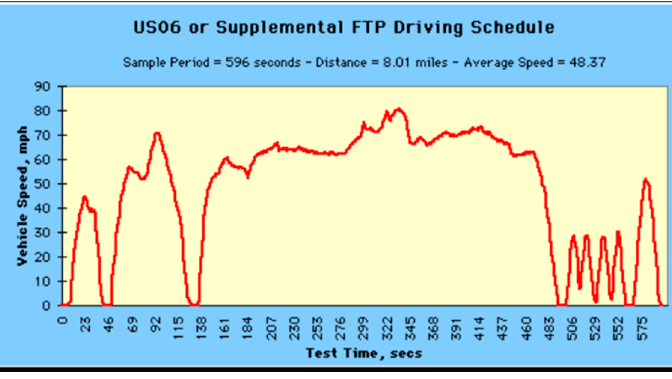
Figure 17. US 06 drive cycle.